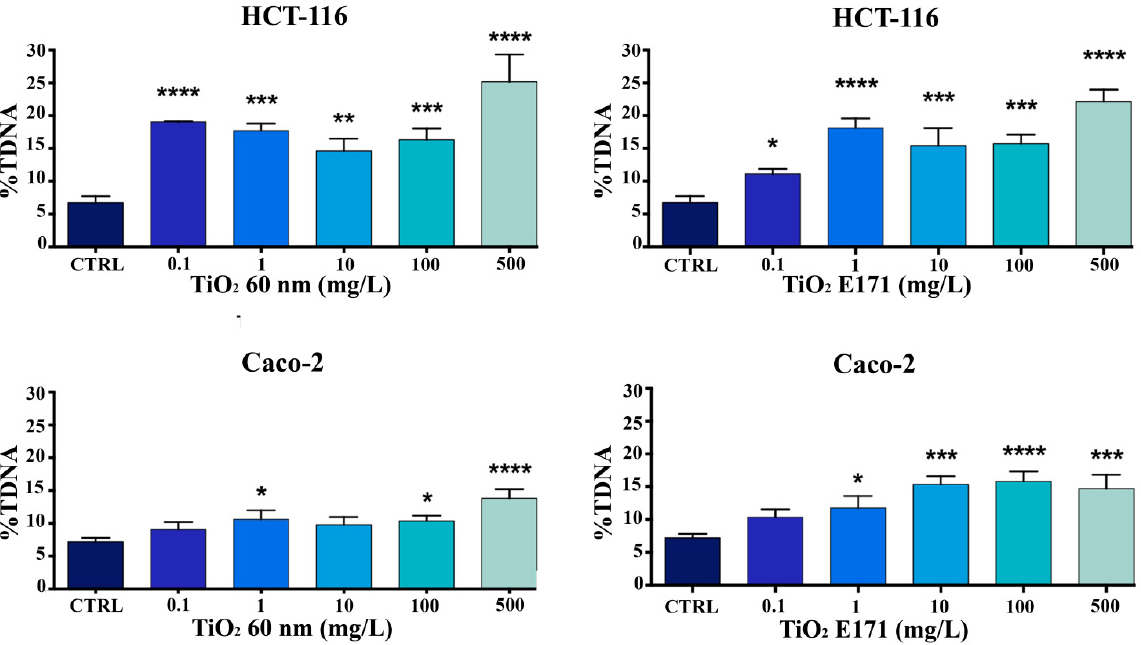
Figure 2. DNA damage was evaluated by alkaline comet assay. HCT-116 and Caco-2 cells were treated with different concentrations of TiO 2 60 nm and E171 for 72 h and investigated by alkaline comet assay. The results were expressed as the percentage of DNA present in the comet tail (%TDNA) and reported as mean ± SD. * p < 0.05 vs. control; ** p < 0.01 vs. control; *** p < 0.001; **** p < 0.0001 vs. control.